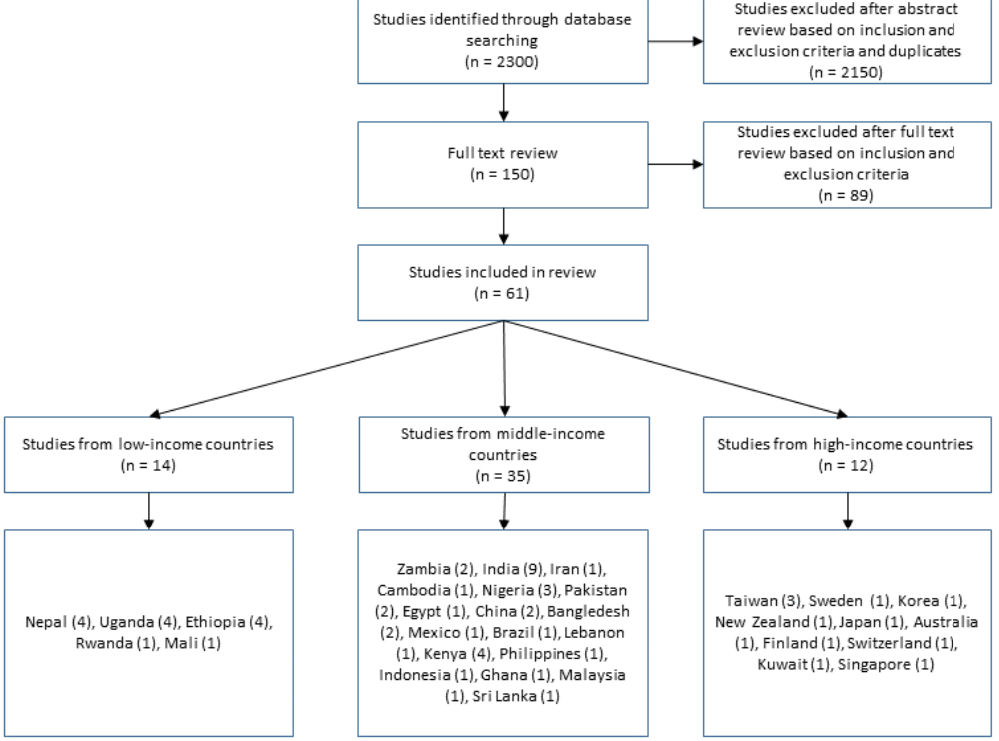
Figure 1. PRISMA flow chart of the search strategy.